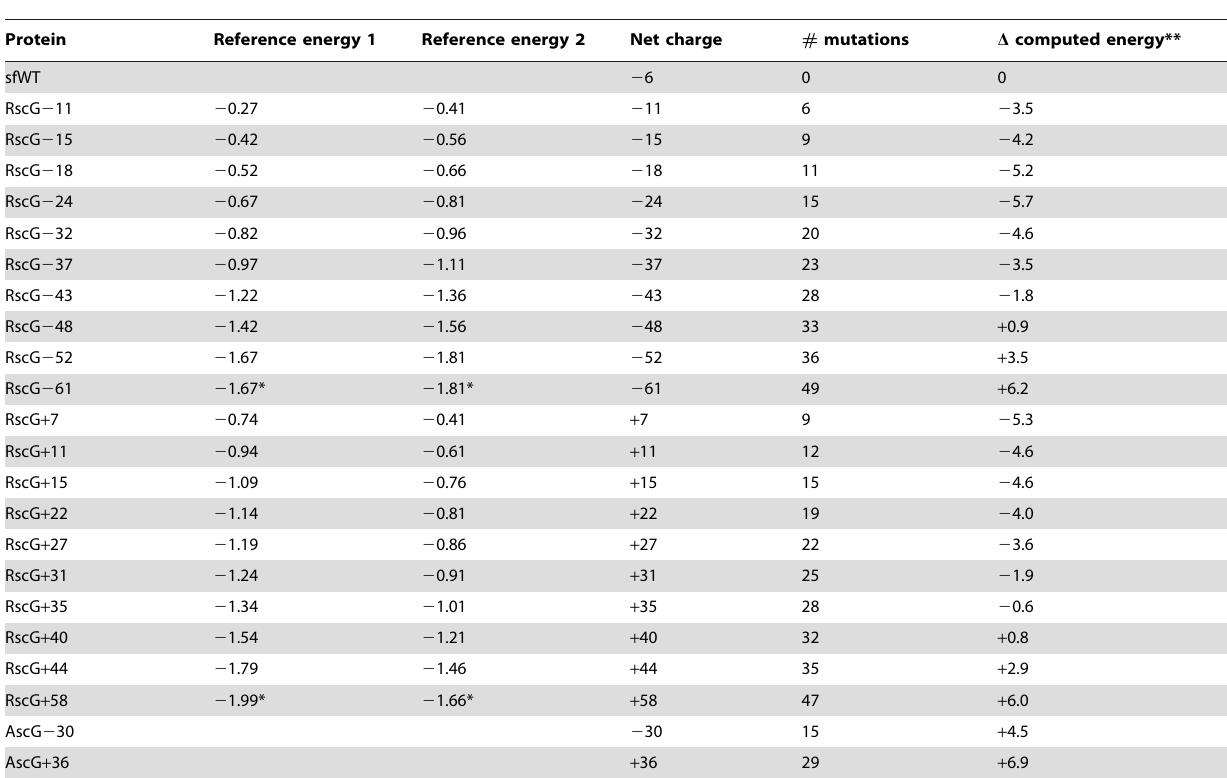
Table 2. Mutations and net charge of supercharged GFP variants.